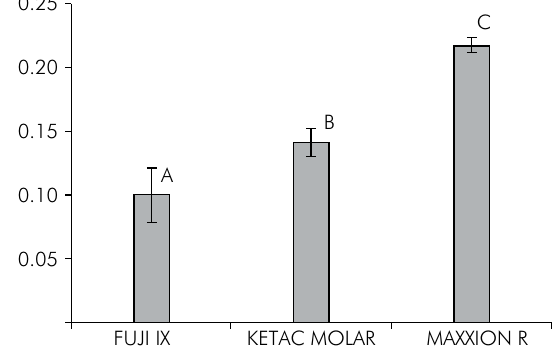
Figure 1. Mean and standard deviation (μg/mm 3 ) of water sorption for all materials tested.